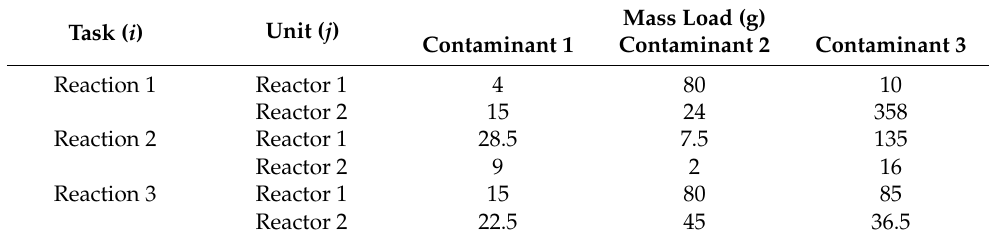
Table A7. Mass loads of various contaminants for case study 2 [7].